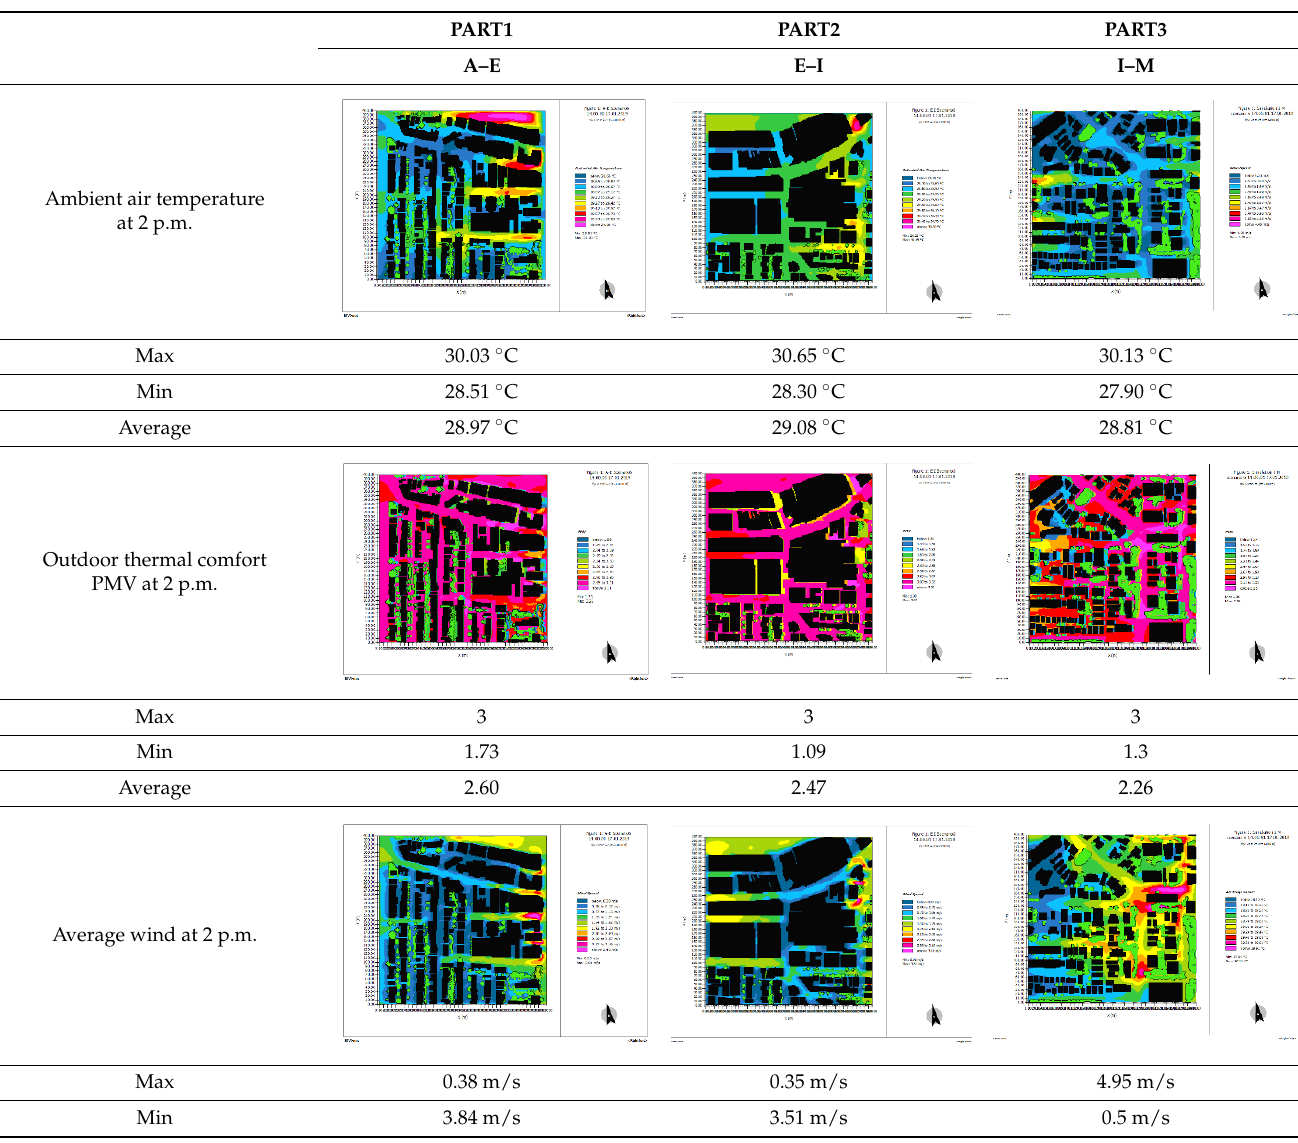
Table 13. Scenario six ambient air temperature, outdoor thermal comfort, and wind speed distribution maps in all parts at 2